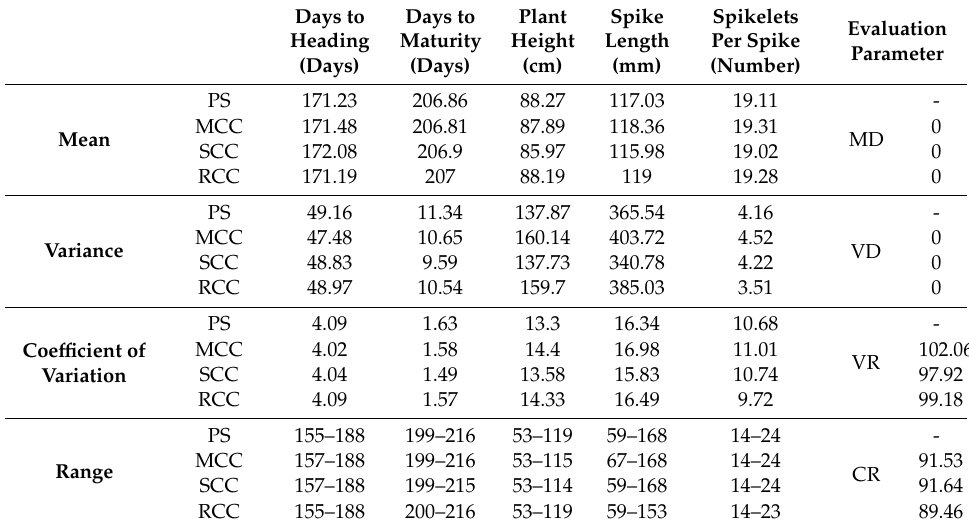
Table 3. Summary statistics for quantitative agromorphological traits in the primary set and core collections.